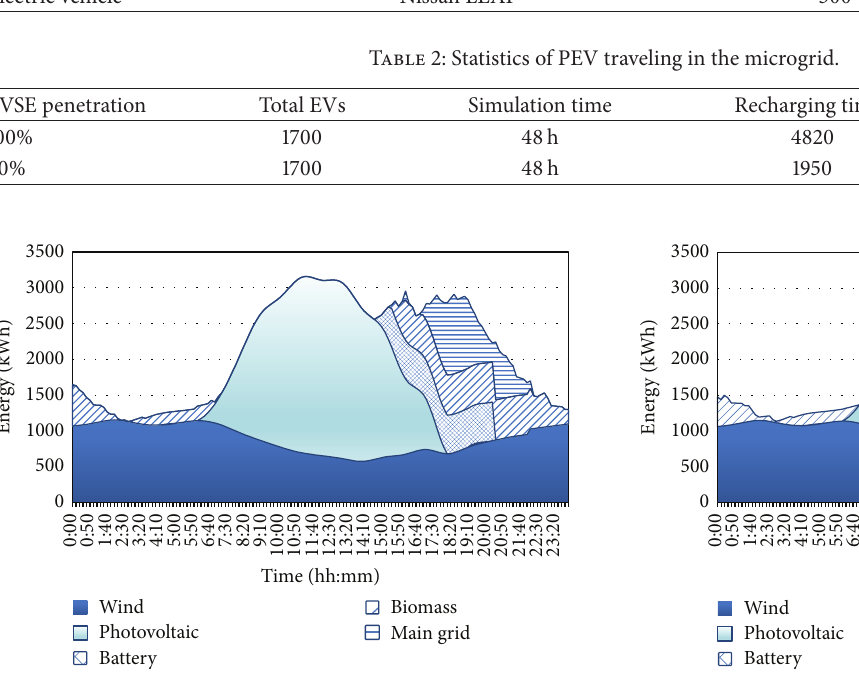
Figure 10: HRES energy supply with 100% EVSE penetration.